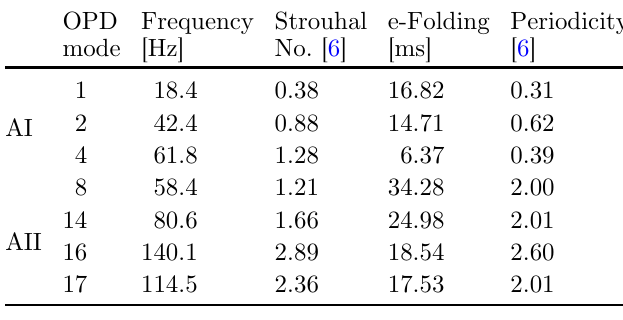
Table 1. Selected OPD modes, branch A.